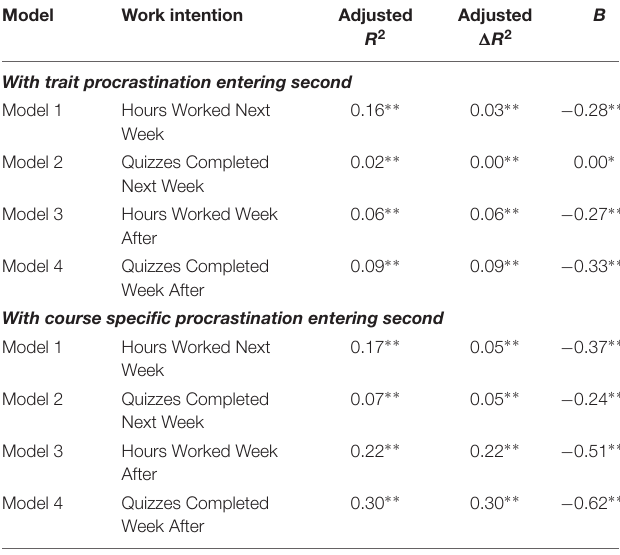
TABLE 4 | Hierarchical regression analyses for determining the incremental predictiveness of self-report procrastination indices above work intentions for predicting observed